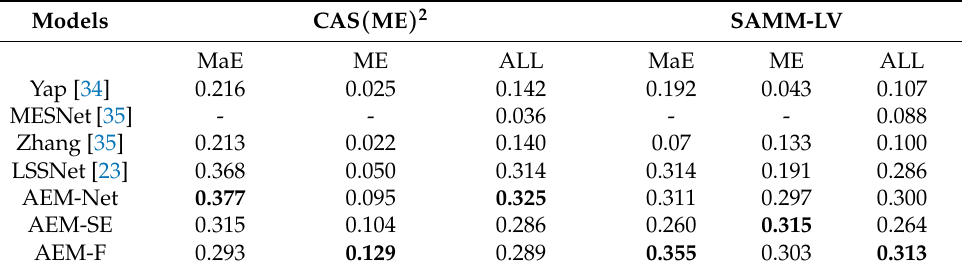
Table 1. Comparison with other spotting methods.